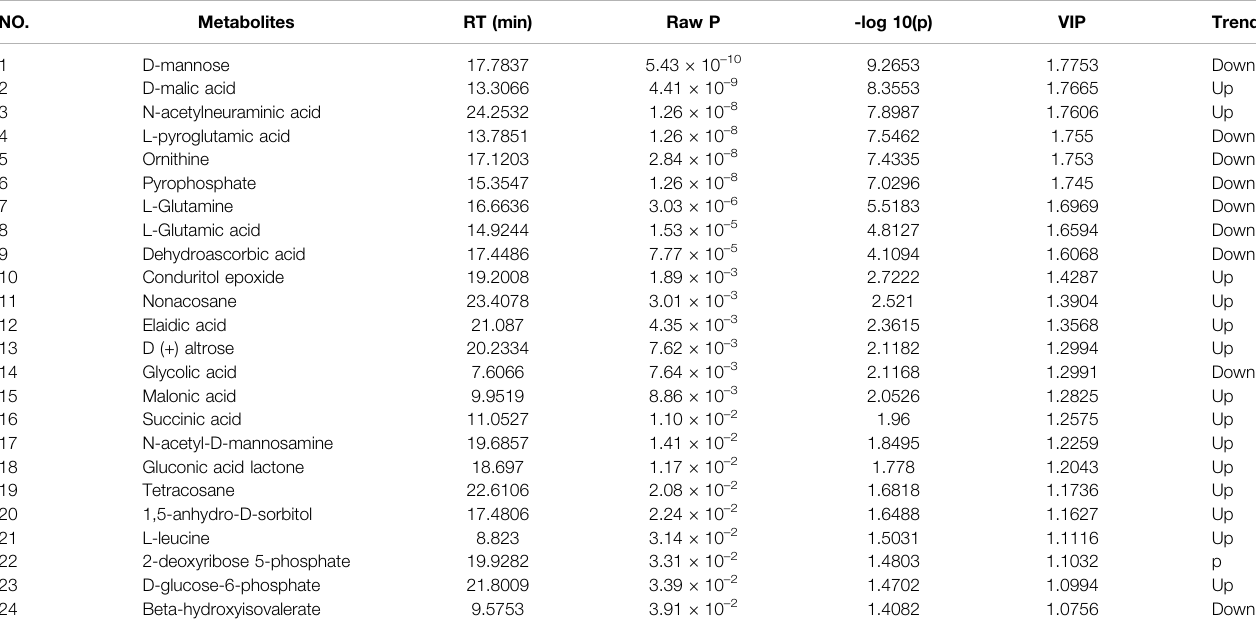
TABLE 1 | Differentially expressed metabolites between the model and QRKSG groups.